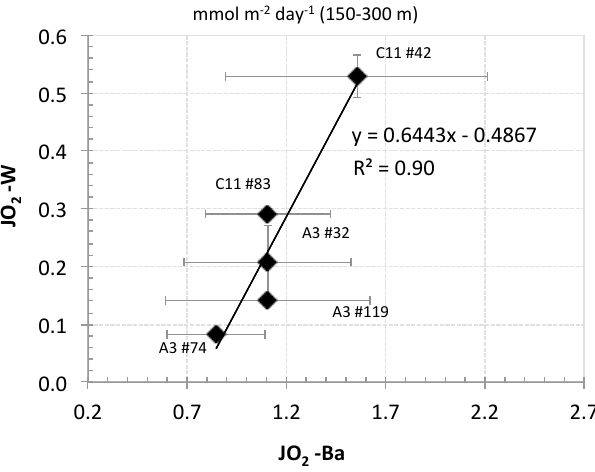
Figure 3. Rates of oxygen consumption (mmolm − 2 day − 1 ) dur- ing KEOPS 1 as directly measured (JO 2 -W) and from mesopelagic Ba xs contents (JO 2 -Ba). Rates are integrated between